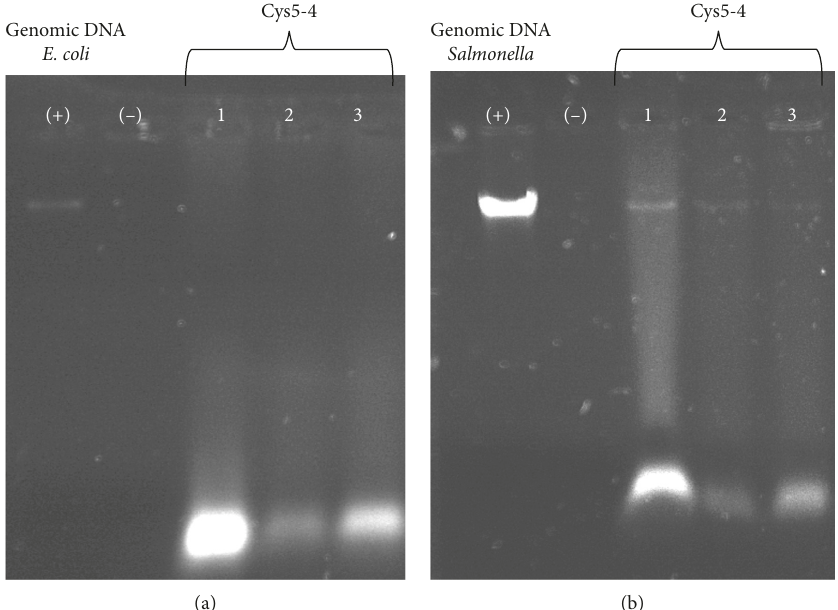
Figure 3: The effect of peptides on the target membrane integrity. (a) E. coli ATCC 25922. (b) Salmonella enterica subsp. enterica ATCC 51741. ( − ): negative control (absence of DNA/RNA molecules in untreated cells); 1–3: DNA/RNA released after treatment with Cys5-4 at different intervals of incubation (1, 2 and 4